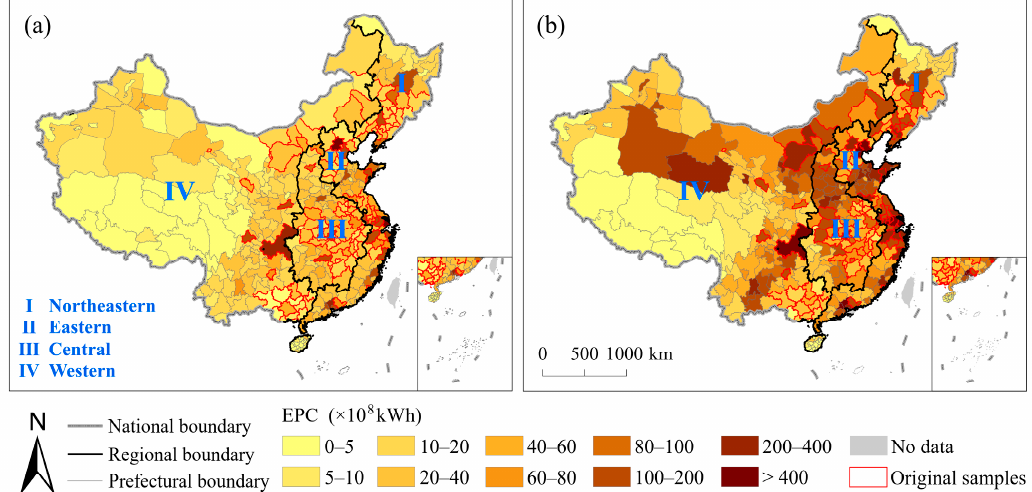
Figure 3. Spatial distribution of ( a ) NEPC and ( b ) IEPC at the prefecture level in China. The 134 prefectures with statistical EPC data are outlined in red.